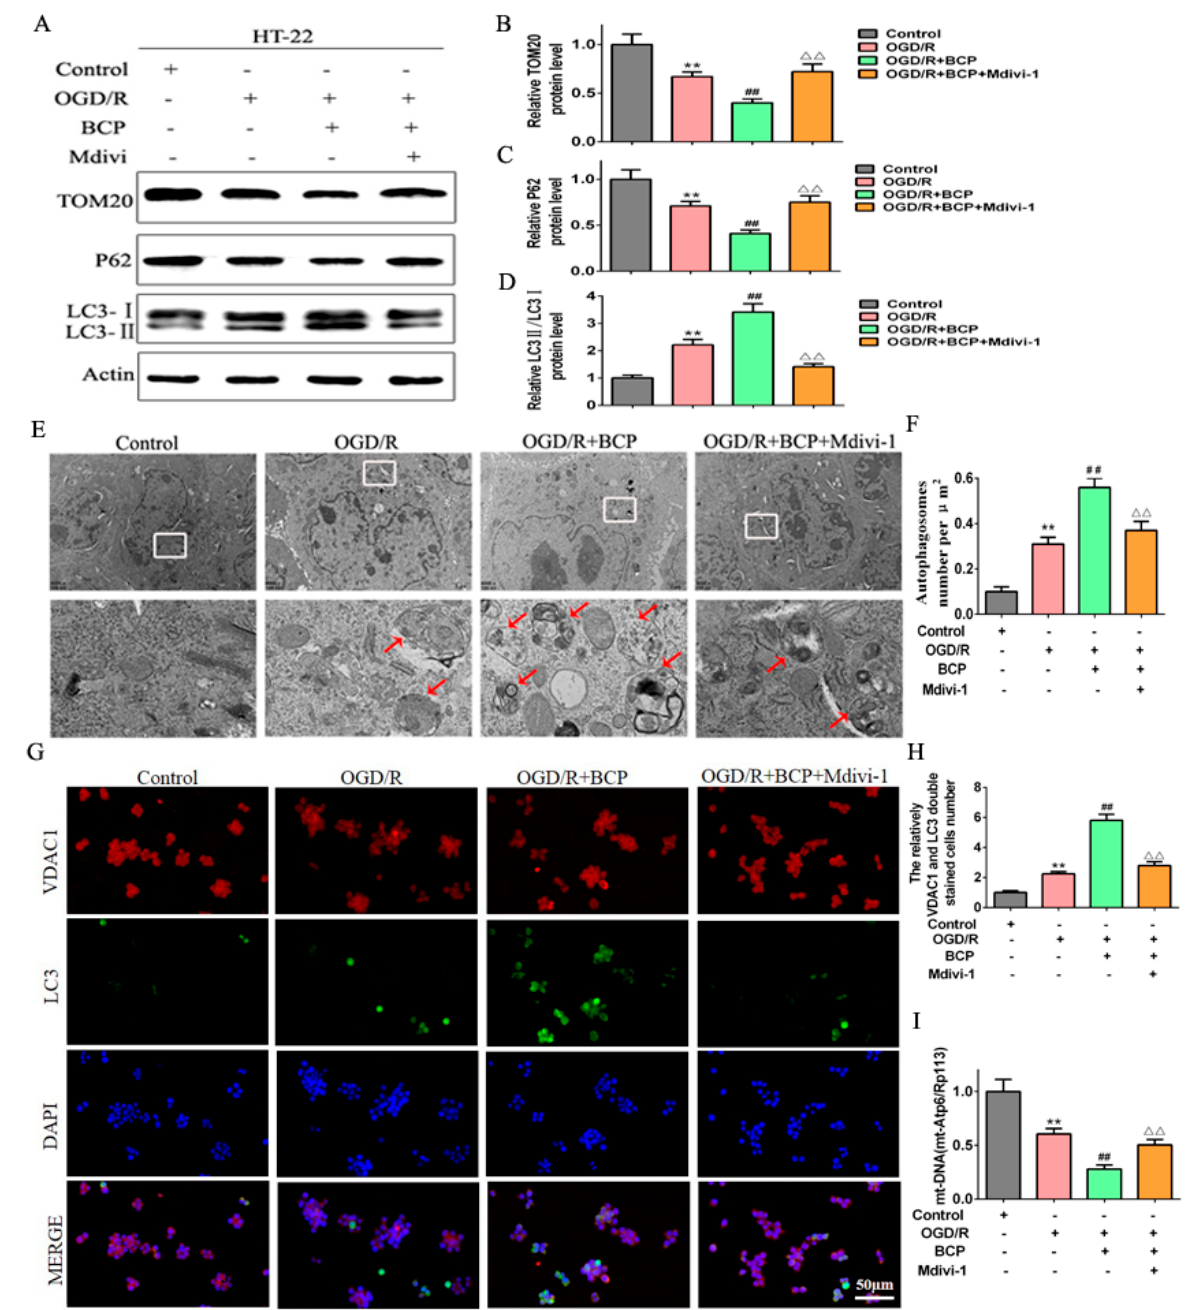
Figure 6. BCP-mediated mitophagy was suppressed by a mitophagy inhibitor. ( A – D ) Representative Western blots showing protein levels of p62 and TOM20, and the protein ratio of LC3-II/LC3-I after treatment with the mitophagy inhibitor Mdivi-1. p62 and TOM20 protein levels were normalized to β -actin. ( E , F ) Transmission electron microscopy revealed that BCP pretreatment increased numbers of autophagosomes in HT-22 cells after treatment with Mdivi-1. (Scale bar = 2 µ m). Red arrows indicate autophagosomes. ( G , H ) Double immunofluorescence staining for LC3B and VDAC1 in HT-22 cells after treatment with Mdivi-1. VDAC1 (red) and LC3B (green) double-stained cells (yellow) indicate mitophagy (scale bar = 50 µ m, 400 × magnification). ( I ) Relative mitochondrial DNA levels indicated by the ratio of mt-Atp6/Rpl13 were assessed by qRT-PCR. ( n = 3; ** p < 0.01 OGD/R group vs. control group; ## p < 0.01 OGD/R + BCP group vs. OGD/R group; (cid:52)(cid:52) p < 0.01 Mdivi-1 group vs. BCP